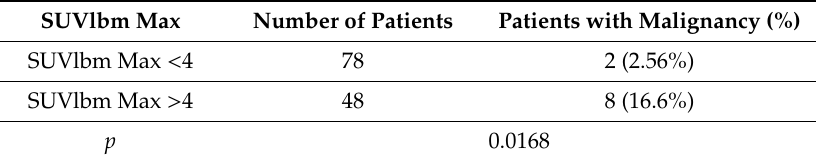
Table 2. SUVlbm Max cutoff value.